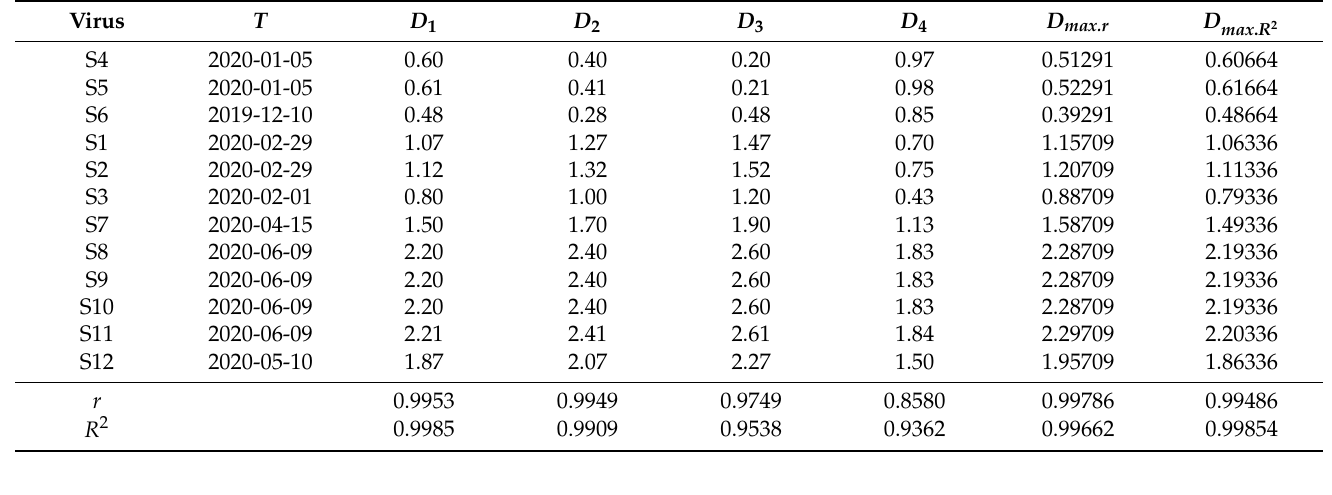
Table 1. Different root-to-tip distances ( D 1 , D 2 , D 3 , and D 4 ) when the candidate root is placed at internal nodes 1, 2, 3 and 4 in Figure 1A, respectively. T is virus collection time in the format of yyyy- mm-dd. The last two rows show (1) the Pearson correlation (r) between T and D and (2) coefficient of determination ( R 2 ) based on D = b 0 + b 1 T + b 2 T 2 .